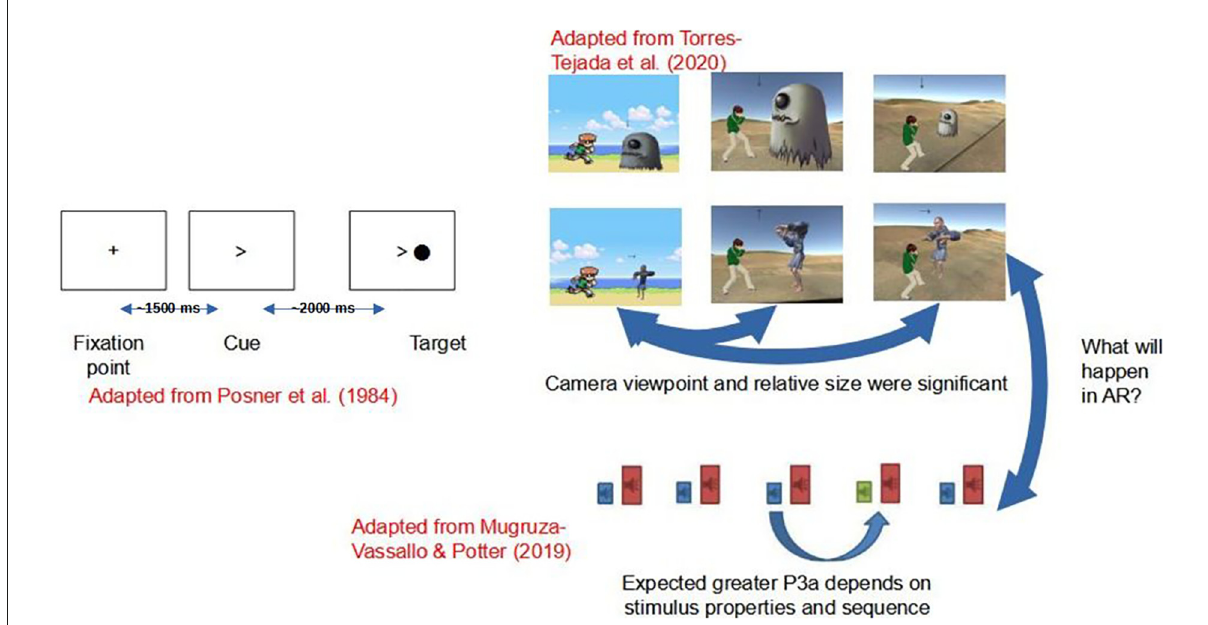
FIGURE1 Experimental screens similar to Posner et al. (1984), Torres-Tejada et al. (2020), and Mugruza-Vassallo and Potter (2019). Those works allow us to make a simplified video-game experiment and also to ask: Are 2D, 3D, and augmented reality (AR) main differences processed able to predict with Markov